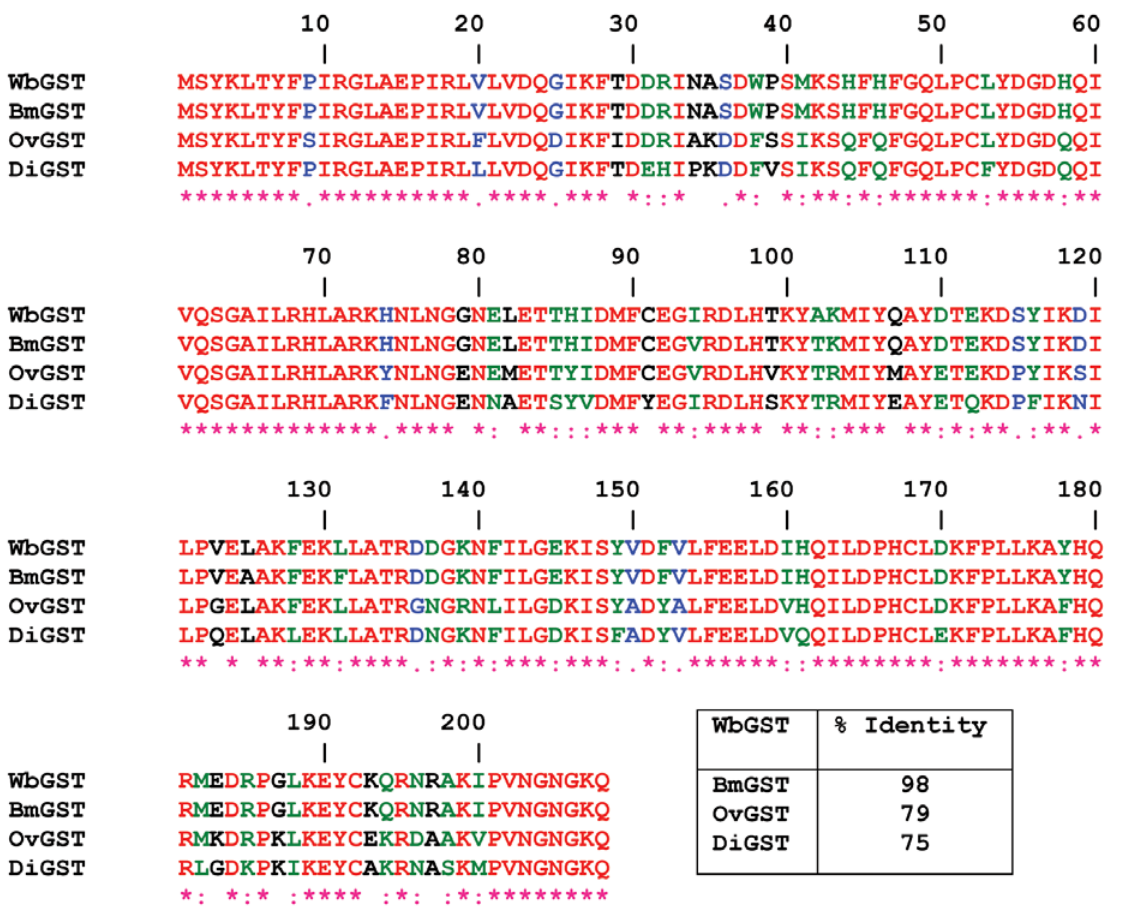
Figure 1. Multiple sequence alignment of WbGST. Multiple sequence alignments (CLUSTAL) of the amino acid sequences of GST family of proteins from W. bancrofti (WbGST; accession no. AY195867), Brugia malayi (BmGST, accession no. Y12788), Onchocerca volvulus (OvGST, accession no. L28771) and Dirofilaria immitis (DiGST, accession no. P46426). The amino acid positions are numbered above the amino acid sequences. Multiple alignment results show that GSTs from filarial parasites are highly identical to each other. (*) red color denotes identical amino acids, (:) green color denotes strongly similar amino acids and (.) blue color denotes weakly similar amino acids.